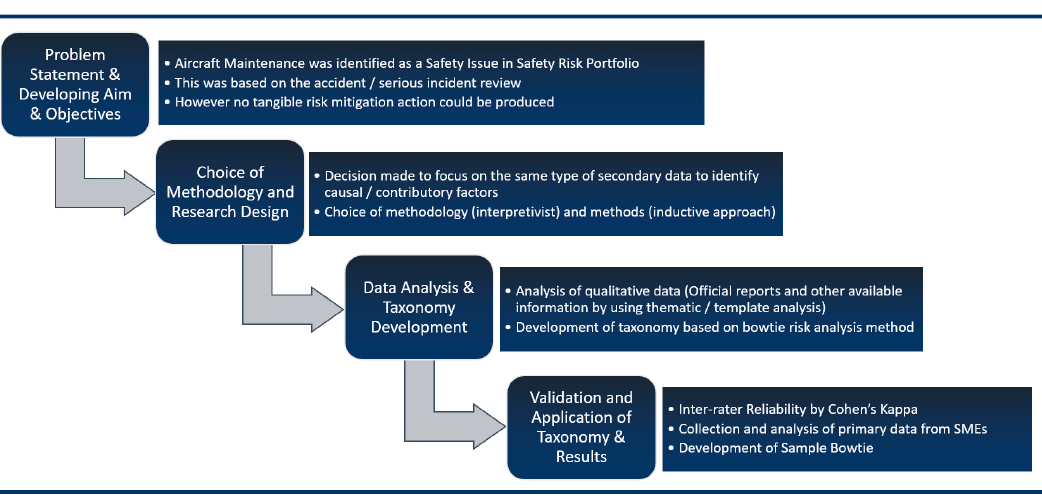
Figure 2. Research design and key steps.